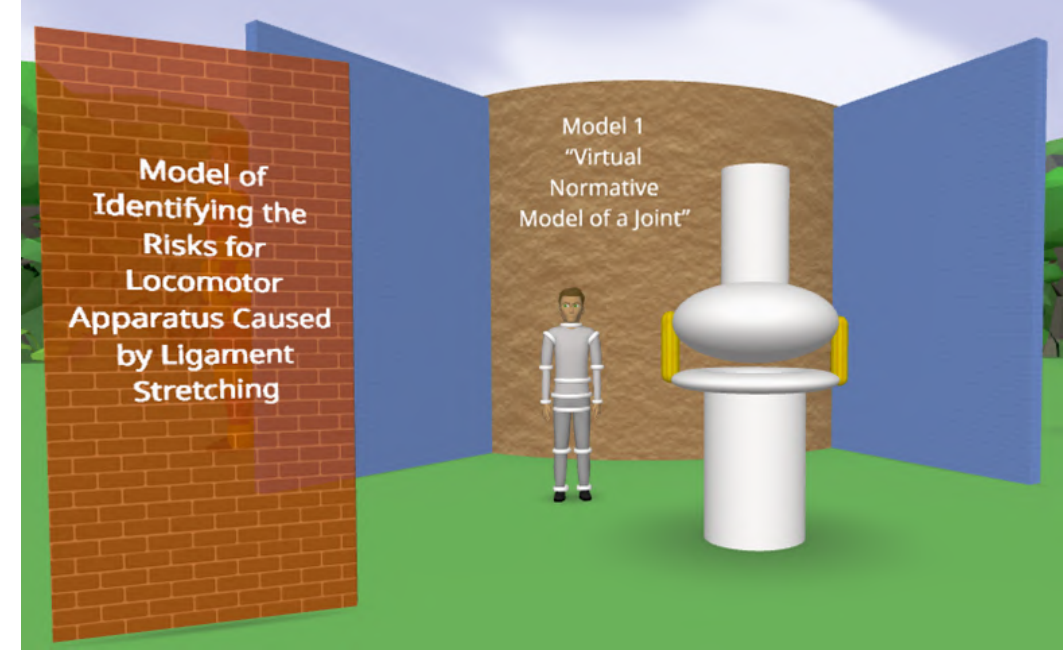
Figure 9: Presentation of paper